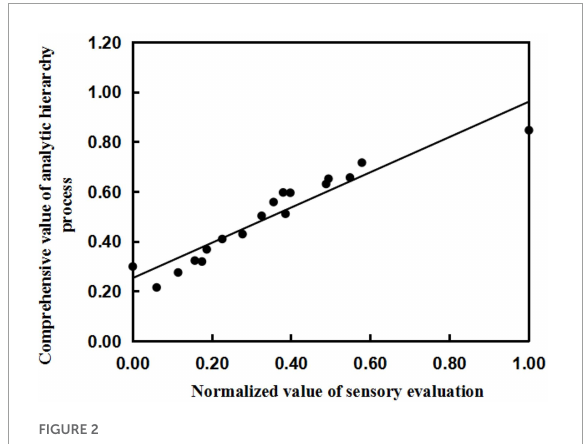
FIGURE2 Fitness test of sensory evaluation sore and analytic hierarchy process value.